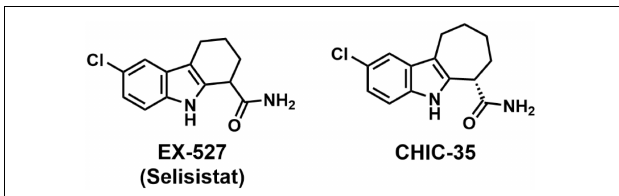
( Table 12 ). In a Phase 1 trial (NCT01521832), EX-527